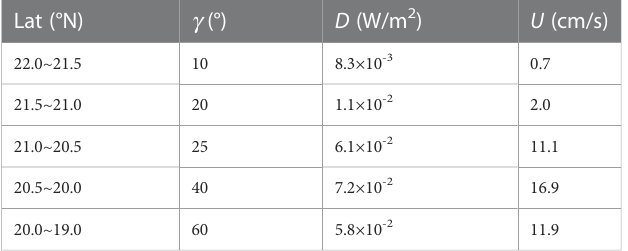
TABLE 2 The theoretically predicted values of the along-slope bottom fl ow velocity U at different latitudes on the northeastern continental slope of the SCS based on the simulations of Wang et al.